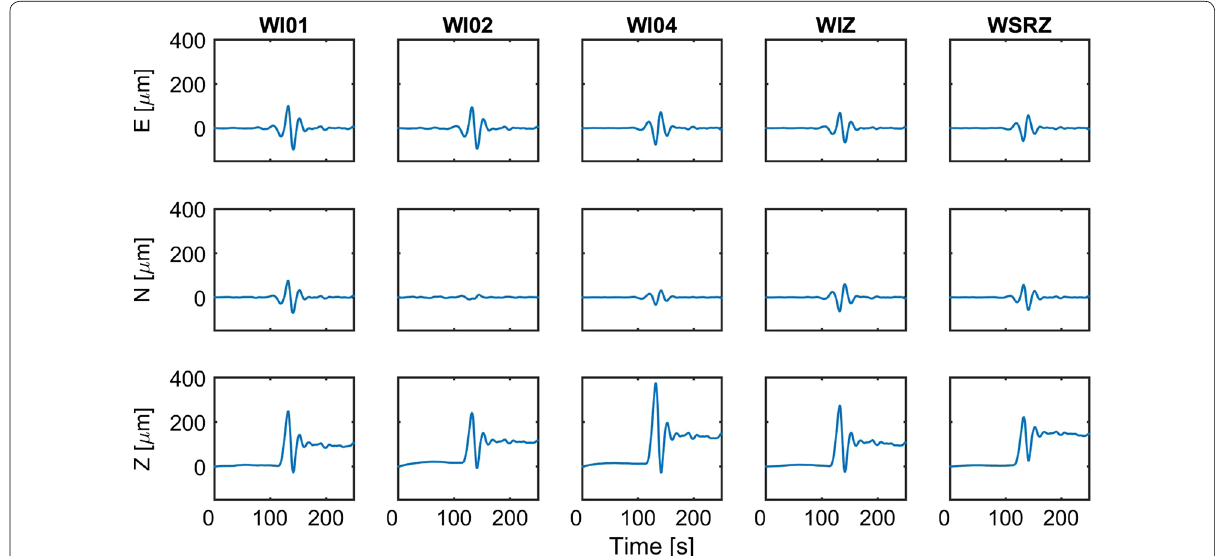
Fig. 7 Filtered displacement waveforms. The horizontal components are band-pass-filtered between 0.03 Hz and 0.1 Hz, while the vertical components are low-pass-filtered below 0.1 Hz and a 100 s median filter was applied to stabilize the displacement